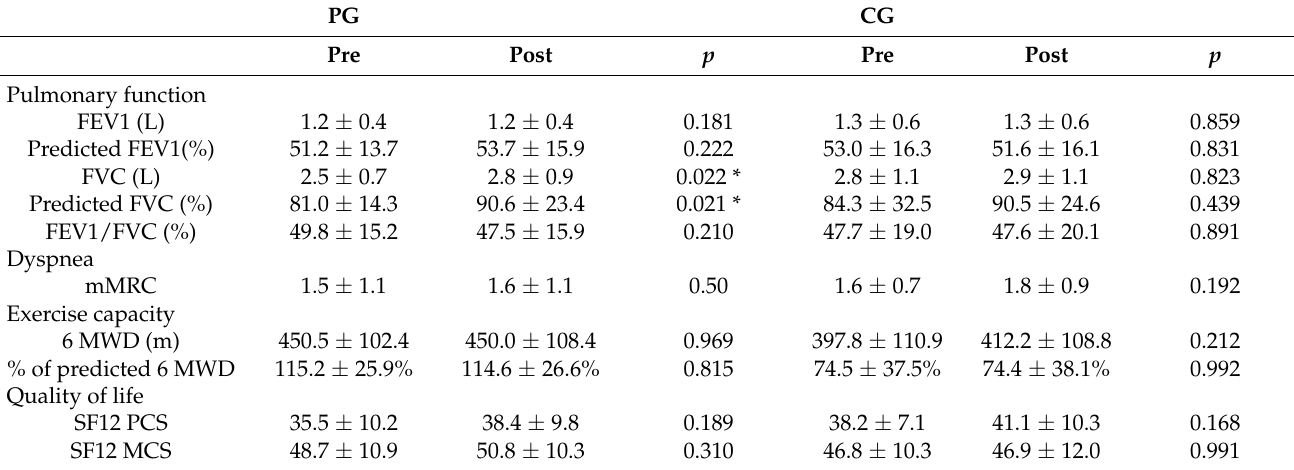
Table 2. Comparisons of outcomes within pedometer (PG) and control group